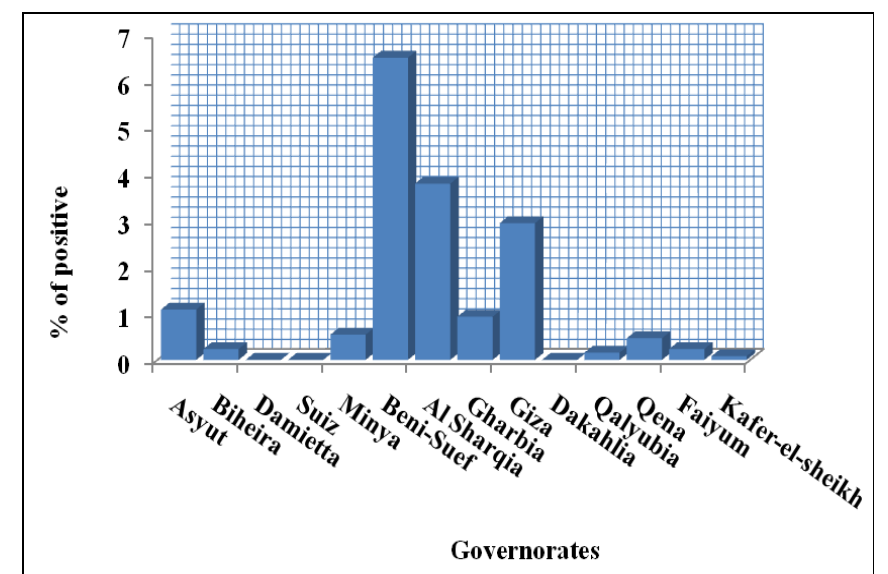
Figure-2. Results of AGPT for detection of BTV specific antibodies in sheep and goats sera collected from different governorates in